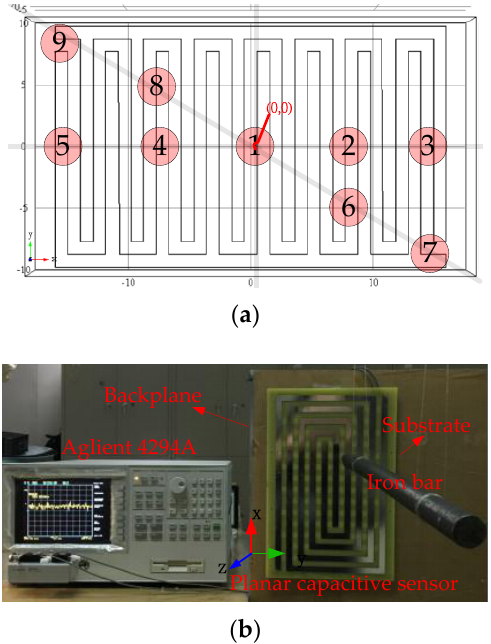
Figure 6. ( a ) Prototype of the spiral electrodes and ( b ) measurement experiment using the precision impedance analyzer (Aglient 4294A).